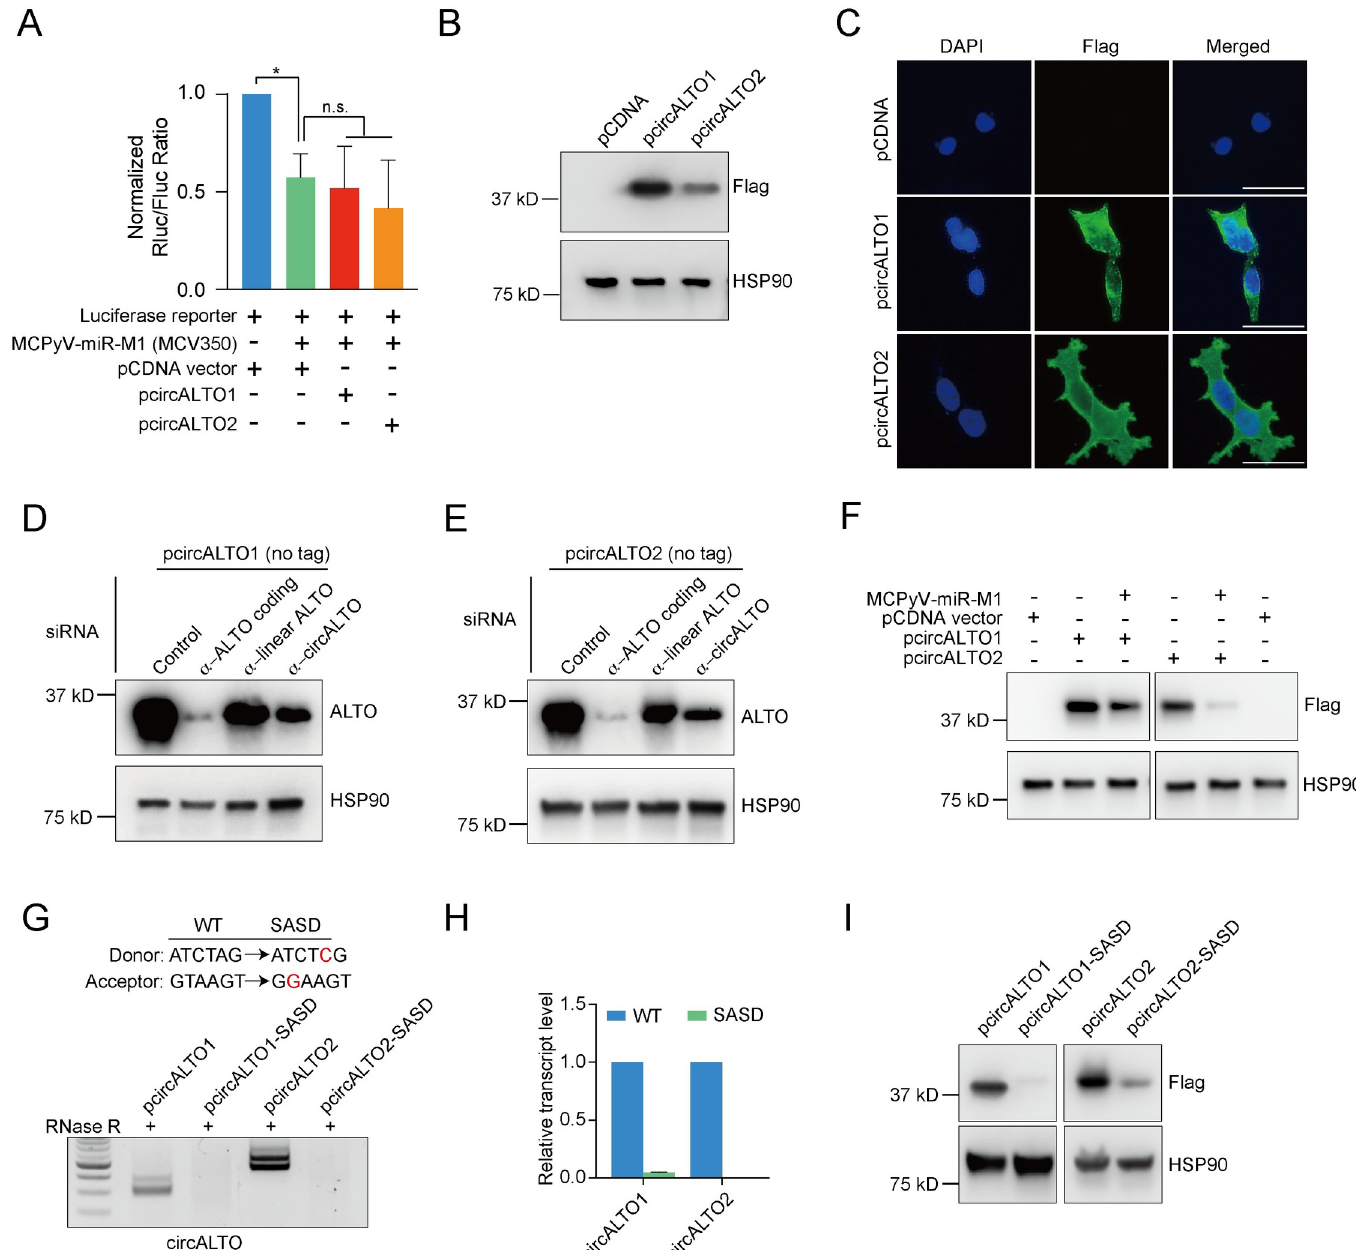
Fig 3. MCPyV circALTO can be translated. (A) CircALTOs do not inhibit MCPyV miRNA function in vitro. 293 cells were transfected with Renilla luciferase reporter with a 300 nucleotide region complementary to the MCPyV miRNA and the indicated plasmids including a MCPyV-miRNA-M1 expression plasmid (derived from isolate MCV350), pCDNA3.1 control vector, pCDNA circALTO1 (pcircALTO1) or pCDNA circALTO2 (pcircALTO2) expression plasmid. Firefly luciferase served as a transfection control and Renilla luciferase levels are plotted normalized relative to firefly luciferase levels (n = 2 biological replicates). The P value was determined by unpaired two-tailed t-test. (B) Western blot (WB) for FLAG from 293T cells co-transfected with a pCDNA vector control plasmid or pCDNA3.1-Flag-circALTO1/2. HSP90, loading control. (C) 293T cells were transfected with vector, the Flag-circALTO1/2 plasmids. After 48 hours, cells were fixed and stained for FLAG (green) and DAPI (blue). Scale bar = 50 μ m. (D) WB for ALTO protein from 293T cells co-transfected with circALTO1 (untagged) and siRNAs targeting the body of the ALTO ORF, a segment unique to linear ALTO transcripts, or an siRNA targeting the unique junction of circALTO1. (E) WB for ALTO protein from 293T cells co-transfected with circALTO2 (untagged). (F) Immunoblotting analysis of 293T cells were transfected with empty vector, pCDNA-circALTO1 (Flag), or pcircALTO2 (Flag) with or without MCPyV miRNA expression vector. Co-transfection with the MCPyV miRNA expression vector results in decreased expression of ALTO. (G) Endpoint inverse RT-PCR detection of analysis for circALTO from 293T cells transfected with pcircALTO1/2 (WT) and the indicated constructs harboring splice sites mutations (SASD) (see S2A Fig). (H) Inverse qRT-PCR analysis of circALTO from cells with WT constructs and constructs harboring SASD mutant (see S2A Fig). ACTB served as the internal